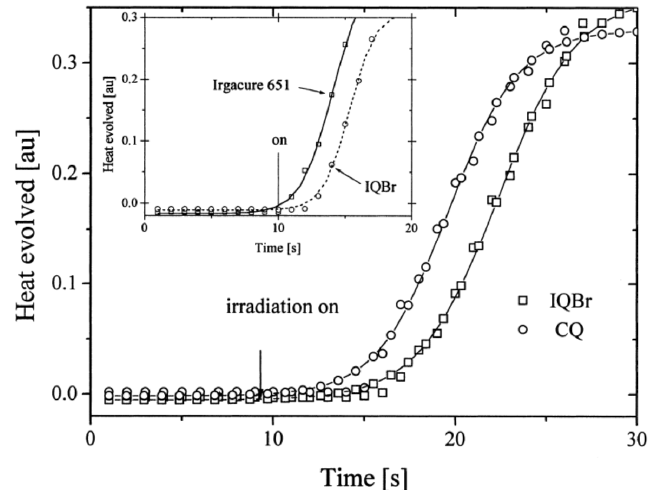
Figure 9. Polymerization profiles obtained during the FRP of TMPTA using IQBr, CQ and Irgacure 651 as the dyes and CN-NPG as the electron donor using a dental lamp as the light source. Reprinted from Ref. [218] . Copyright (2004), with permission from Elsevier.